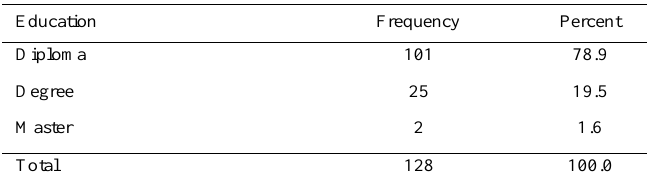
Table 5 <Number of Respondents based on the Educational